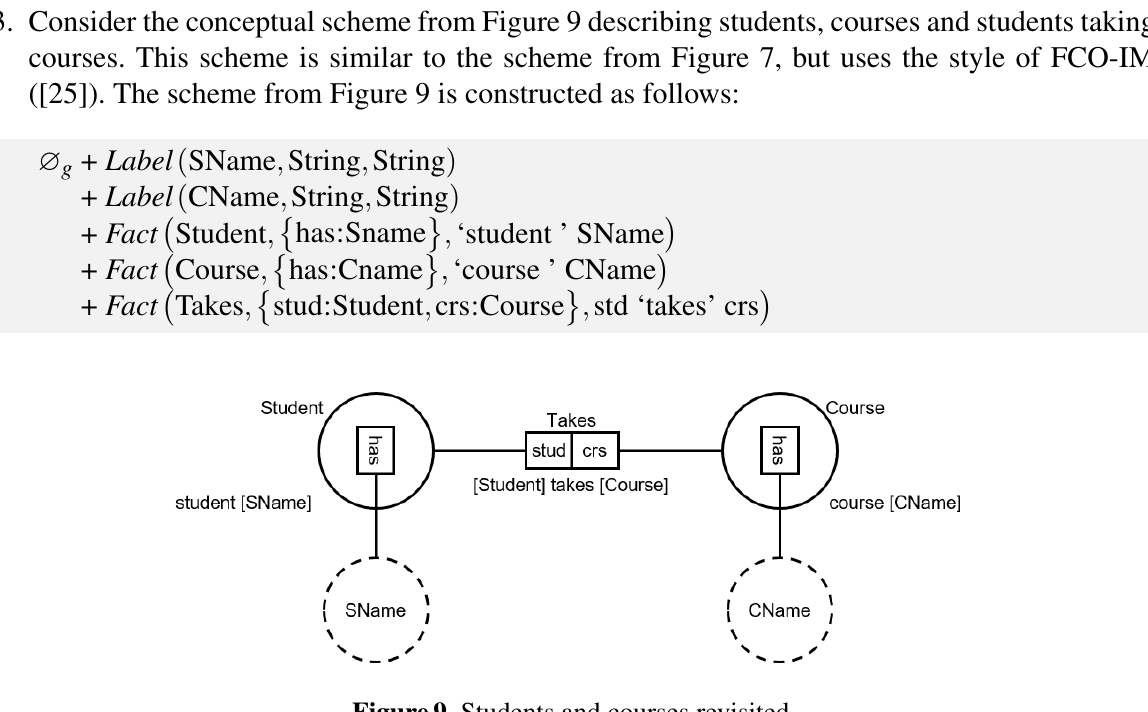
Figure 9. Students and courses